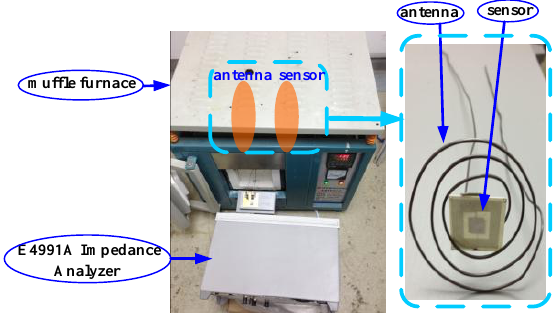
Figure 11. High temperature measurement